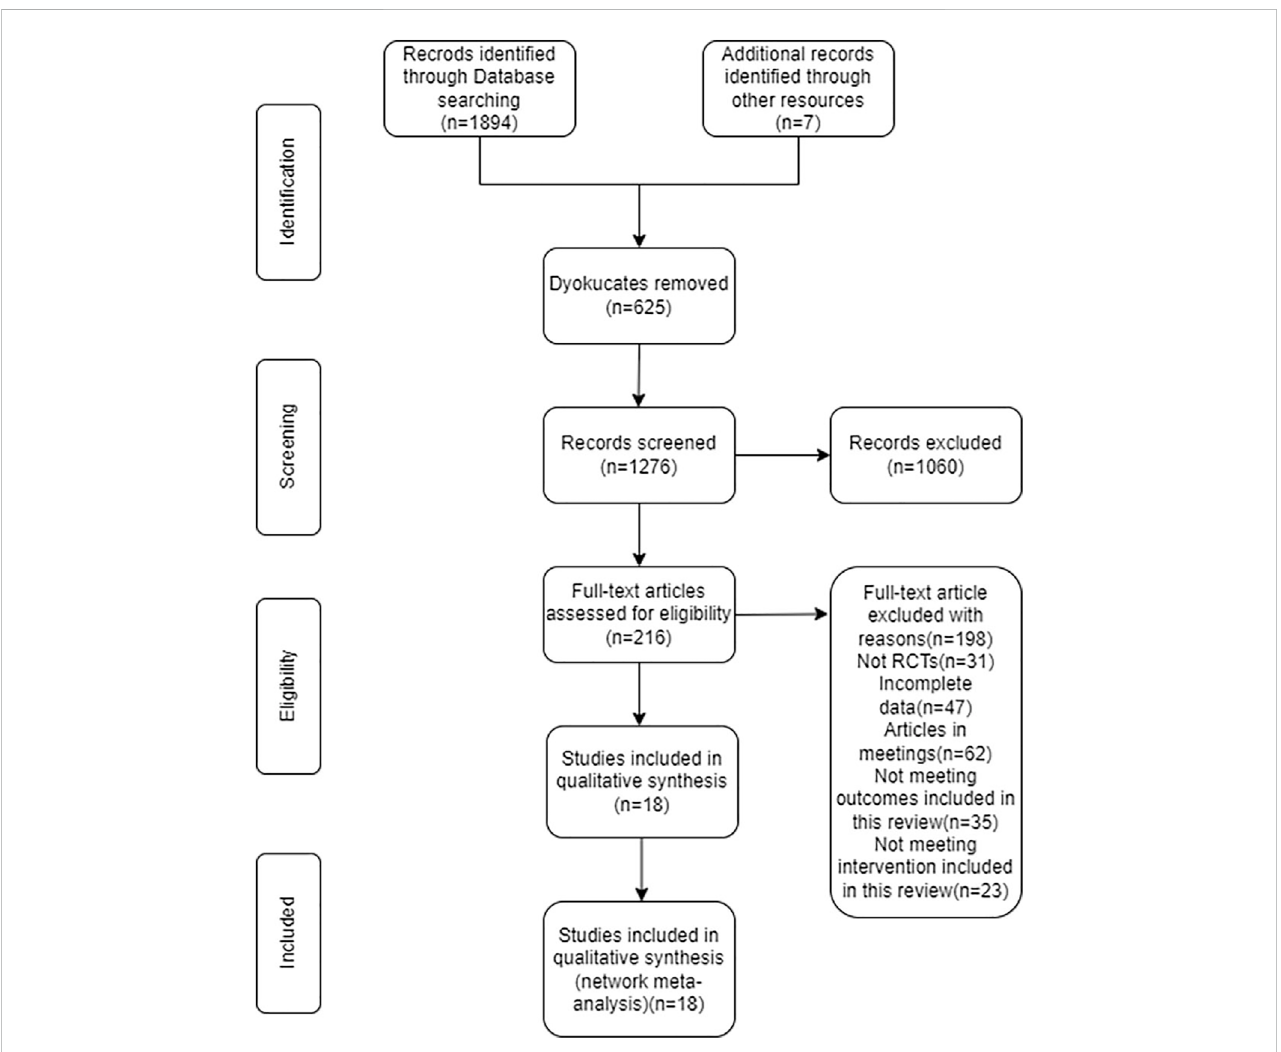
FIGURE 1 Flow diagram of literature selection. This fi gure showed the procedure for including RCTs with participants who have non-diabetic NAFLD.